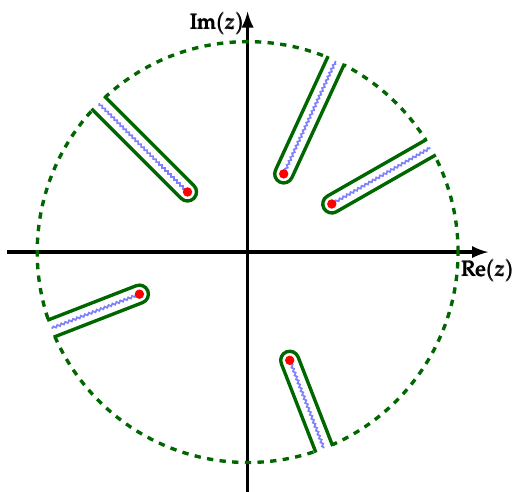
Figure 1. Complex plane with m = 5 cuts (undulate blue curves). Each cut is encircled by a path going to infinity while never crossing any cut. Dashed green lines connect at infinity the full green lines and overall create a closed path which is clearly contractible in 0.